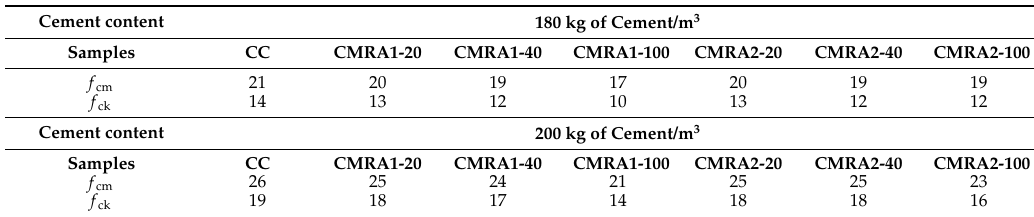
Table 9. The f ck values estimated by ACI Code 318-08.